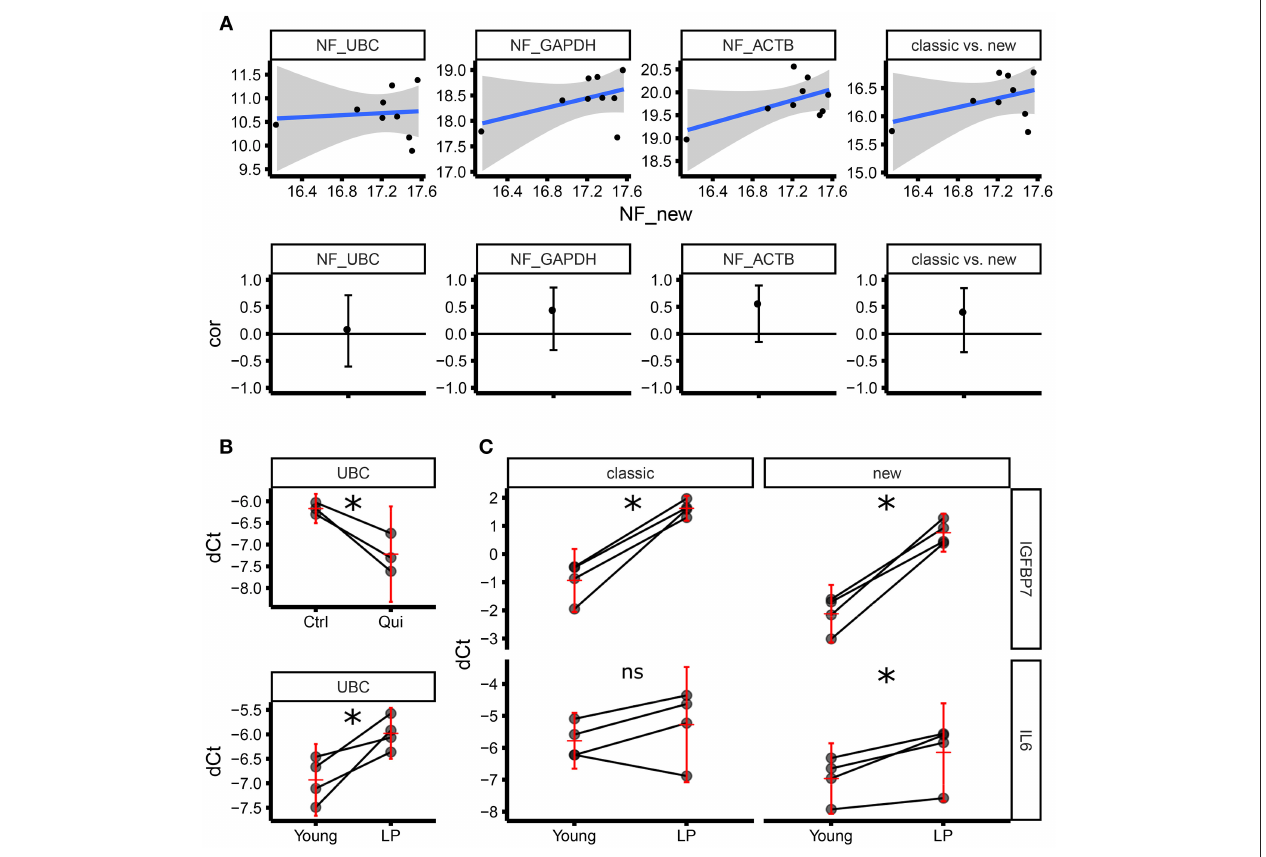
FIGURE 4 | Normalization factor using “classic” housekeeping genes does not correlate with our new geNorm-based housekeeping panel. (A) The upper panel shows the scatter plots comparing normalization factors (NFs) from single genes (UBC, GAPDH, ACTB) or the geometric average of the expression of the three (classic) vs. the new NF based on the genes identified by this study (RPL13, RPL31, RPL37, RPL30). The lower panel shows the estimate of the Pearson correlation r (the black dot) and its 95% confidence interval (vertical black line) for each of the scatter plots above. All the confidence intervals include zero (horizontal black line), therefore we can conclude there is not enough evidence of a correlation between any of the classical NFs and the new NF. (B) Level of expression (qPCR) for UBC as dCt using the new NF. The upper panel shows the expression in three biological replicates (three independent ECFC clones) in control vs. quiescence (matched samples). The lower panel shows the expression in four biological replicates (four independent ECFC clones) in young vs. late passage (LP) (matched samples). The horizontal red line corresponds to the estimate of the average expression in the treatment group. The vertical red line is the 95% confidence interval of the estimate of the average expression. (C) Level of expression (qPCR) for IGFBP7 (upper panel) and IL6 (lower panel) as dCt, using either the new NF (right side) or the classical NF (left side) in four biological replicates (matched samples). IGFBP7 is significantly upregulated (as expected comparing LP vs young cells) using both the classical NF and the new NF. IL6 is significantly upregulated (as expected comparing LP vs young cells) only using the new NF. The horizontal red line corresponds to the estimate of the average expression in the treatment group. The vertical red line is the 95% confidence interval of the estimate of the average expression. * p <0.05; ns, not